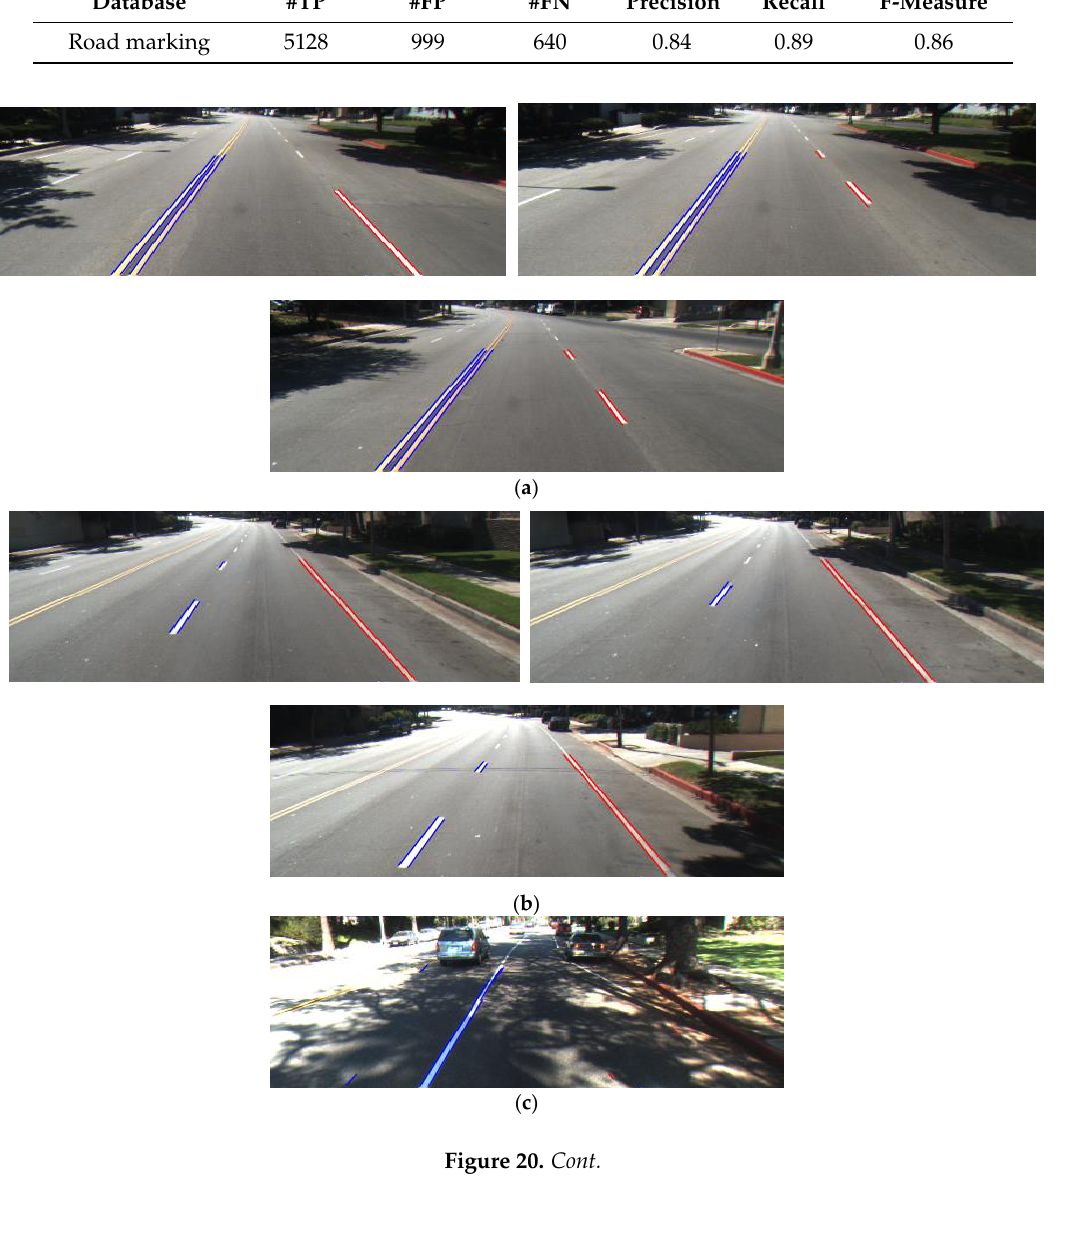
Table 6. Experimental results by our method with the Road Marking datasets.